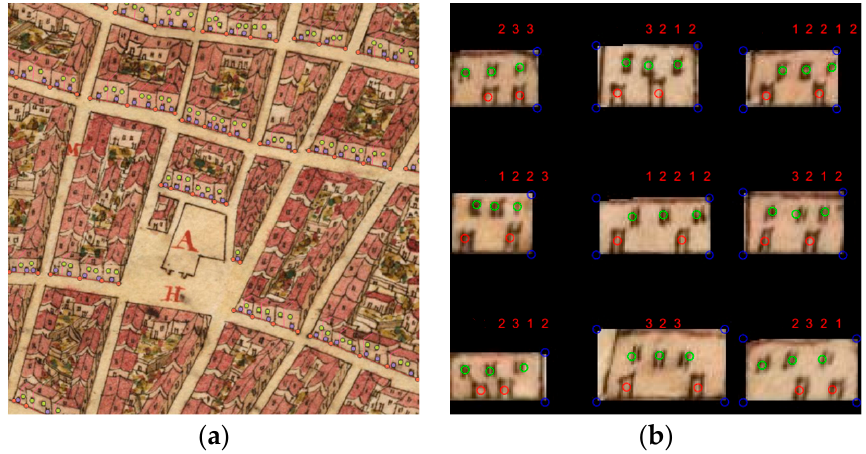
Figure 8. ( a ) Digitization of facade elements. ( b ) Coding of the facade elements ( fcode in red). Door